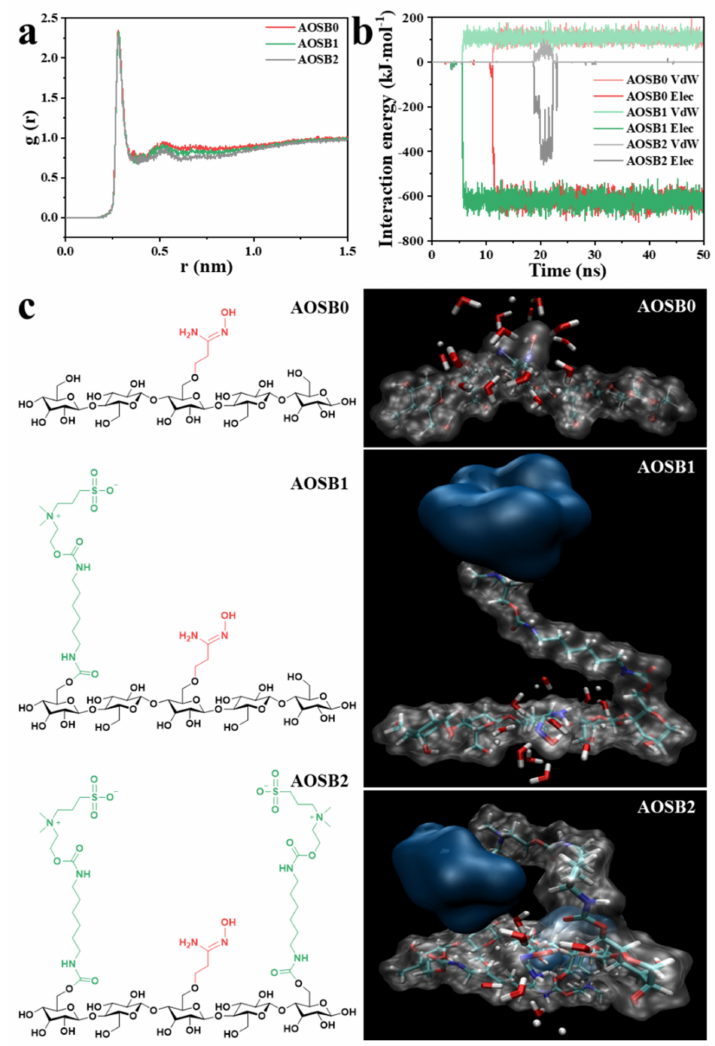
Figure 1. RDF of water molecules around AO groups ( a ); interaction energy between AO groups and U(VI) ions ( b ); disposition of water molecules around AO groups ( c ) for AOSB0, AOSB1, and AOSB2. White: H; green: C; blue: N; red: O; the blue cloud stands for hydration layer by terminal SO 3 −